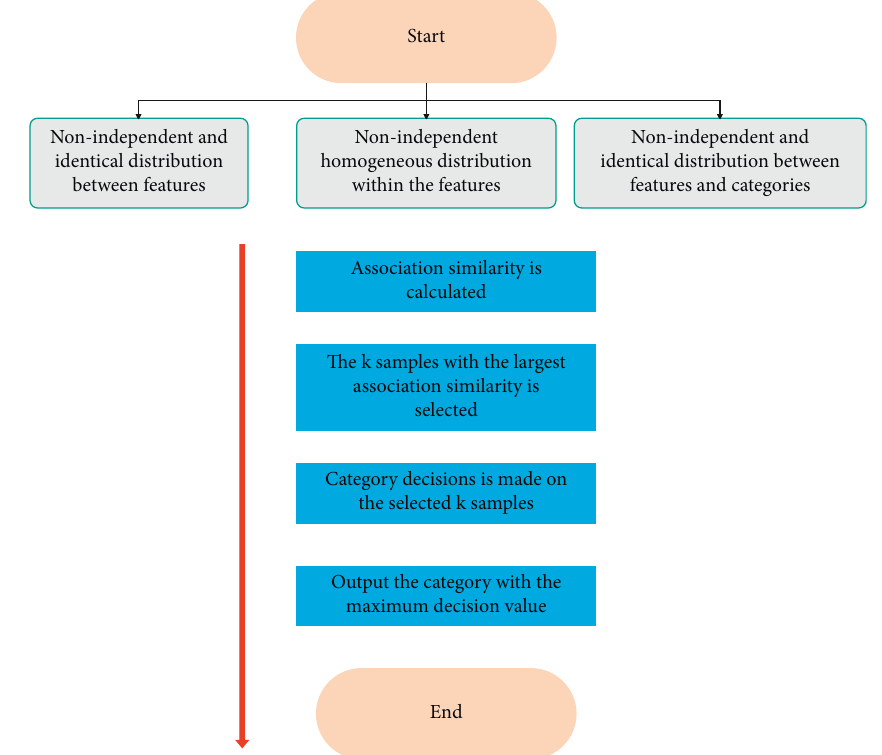
Figure 4: CS_KNN algorithm flow